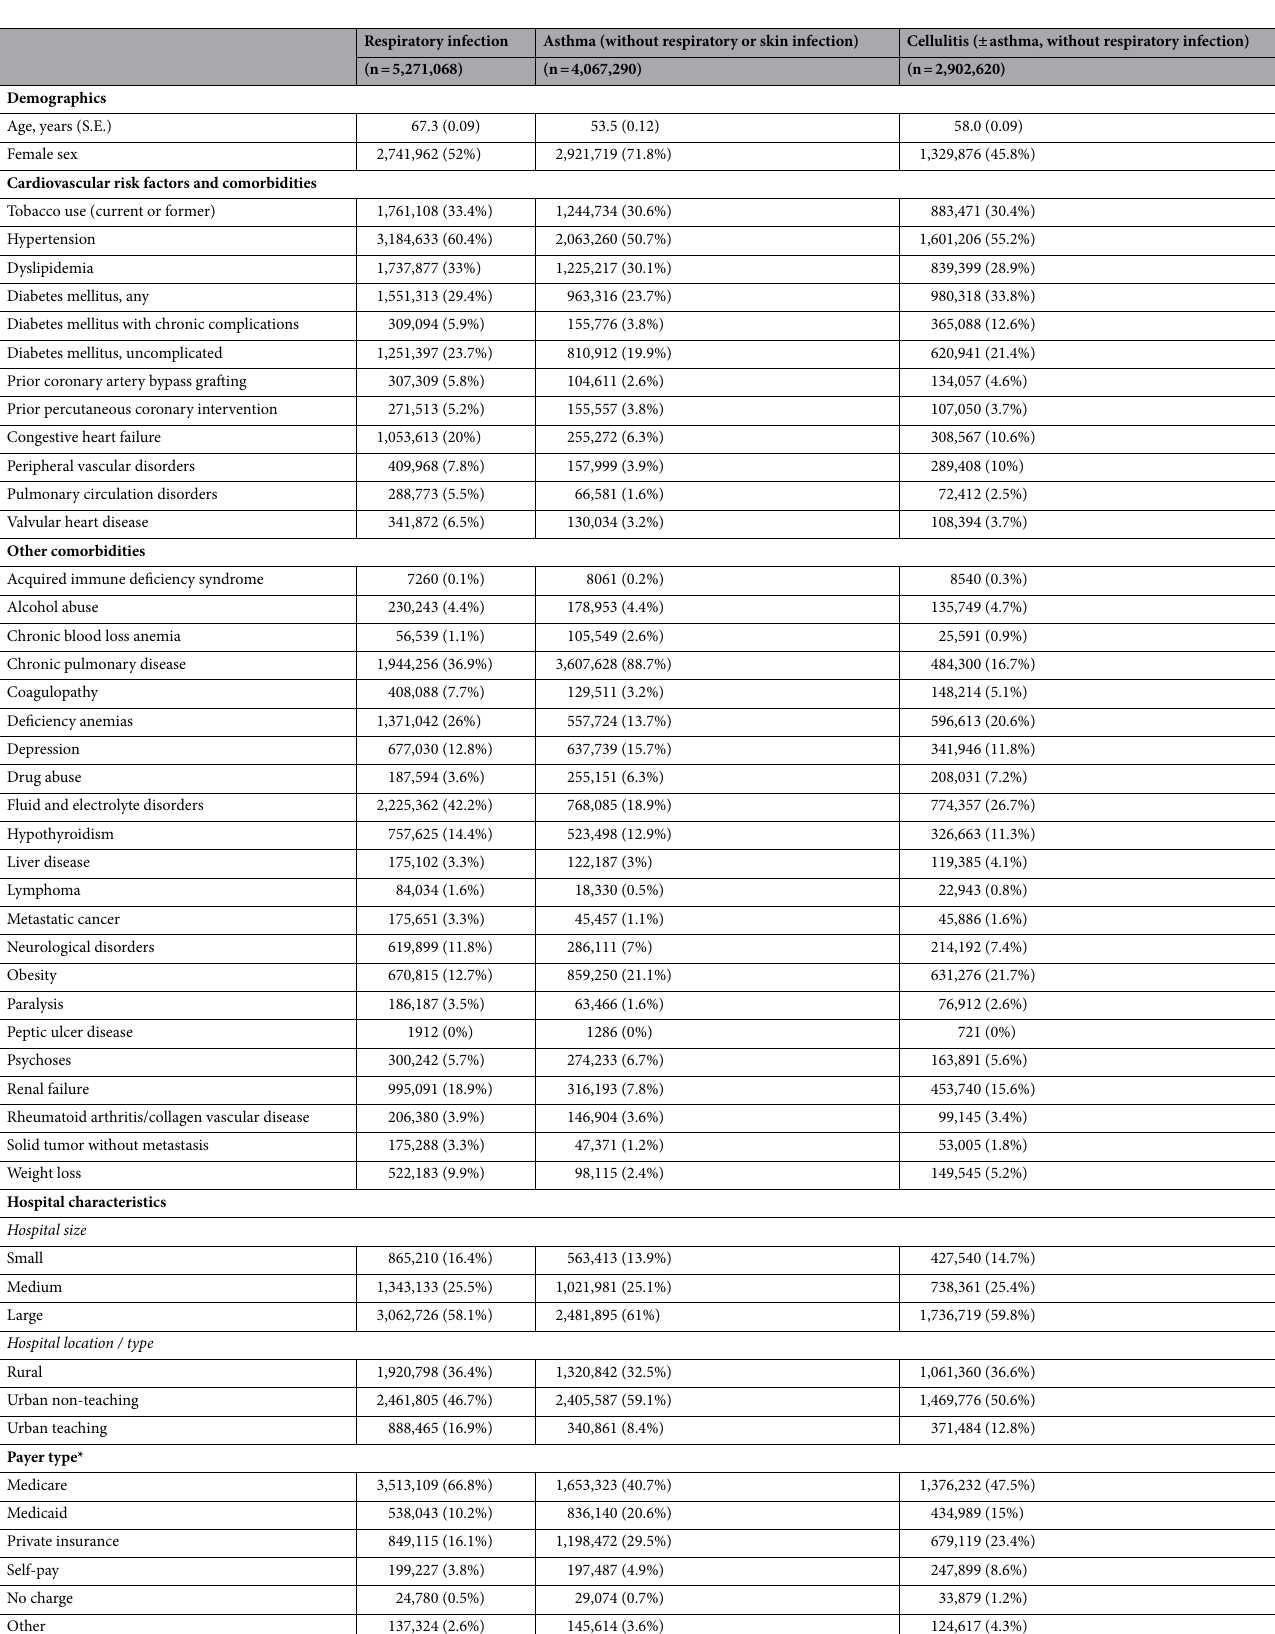
Table 1. Baseline characteristics of patients hospitalized with respiratory infection, asthma, and cellulitis. All P values < 0.001. *Data available for a subset of 99.8% of cases (n =